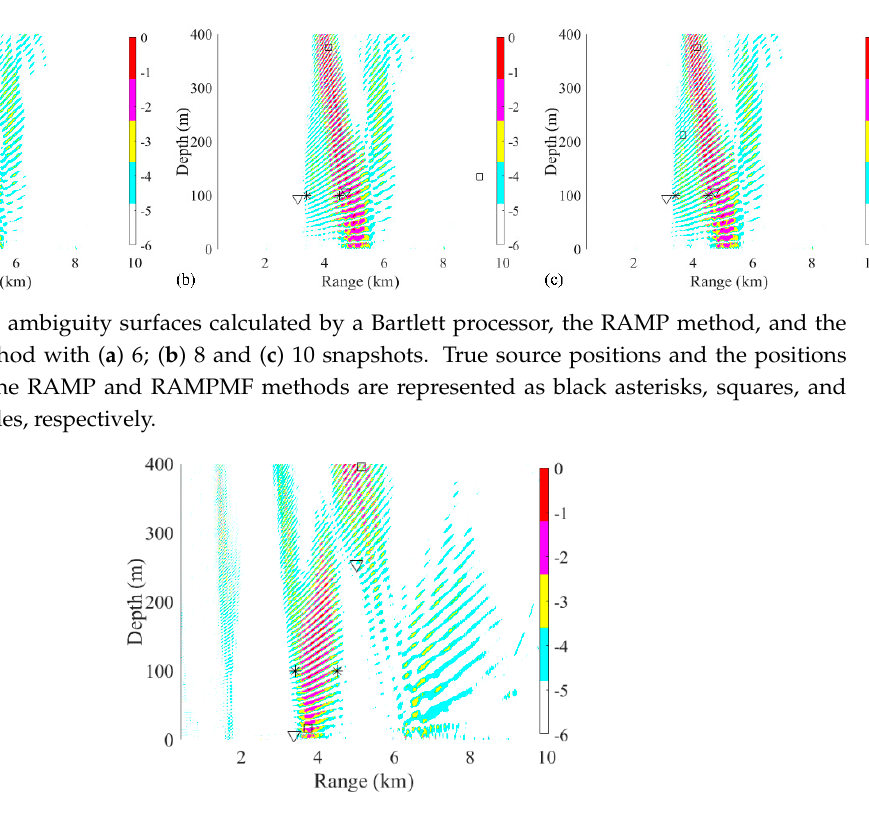
Figure 17. The ambiguity surfaces calculated by a Bartlett processor, the RAMP method, and the RAMPMF method with the apertures ( a ) 94 m; ( b ) 100 m; and ( c ) 112 m. True source positions and the positions estimated by the RAMP and RAMPMF methods are represented as black asterisks, squares, and inverted triangles, respectively.